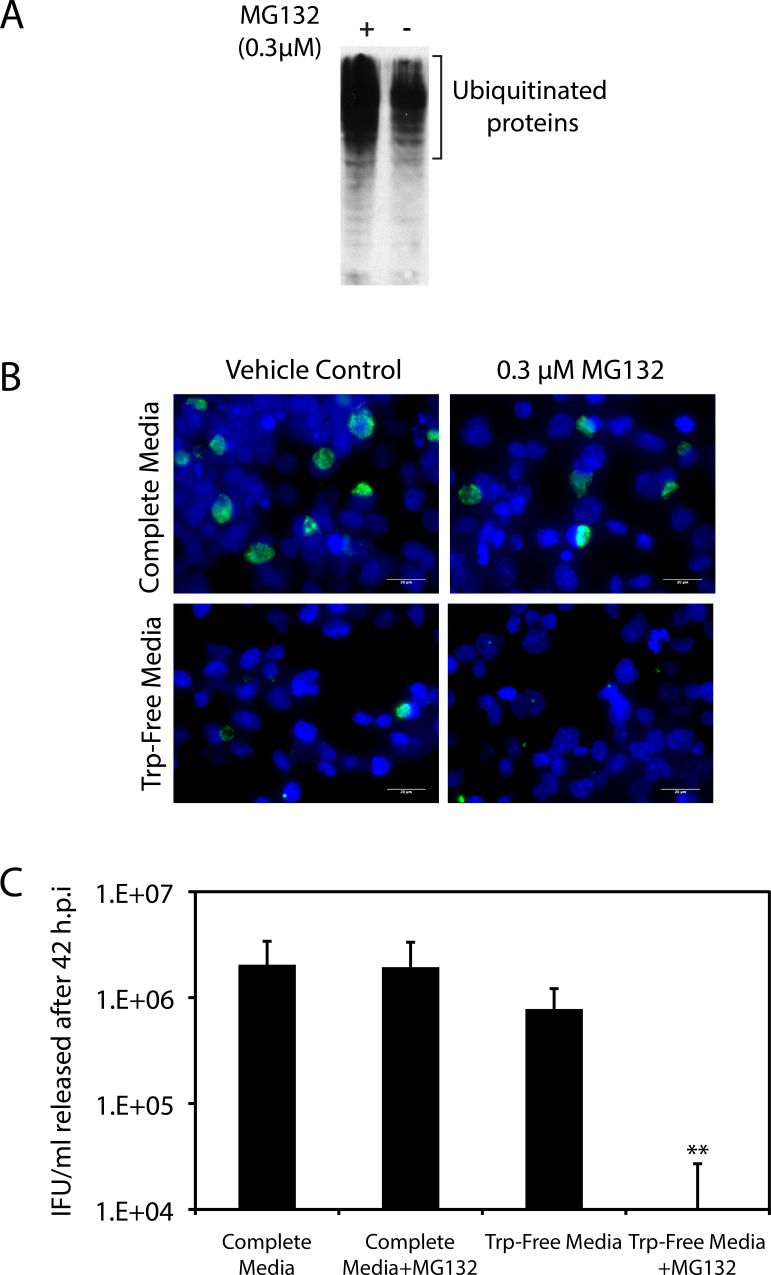
Proteasome activity is essential to support chlamydial development in C33A cells during tryptophan starvation.Immediately after infection with C. trachomatis, C33A cells were grown under four conditions: Complete media + vehicle control; Complete Media + 0.3 μM MG132; Trp-free media + vehicle control; and Trp-free media with 0.3 μM MG132. After 42 hours of growth under these conditions, inclusion development and IFU recovery was evaluated. A) Immunoblot evaluating the accumulation of polyubiquitinated proteins in C33A cells 24 hours post-exposure to the vehicle control or 0.3 μM MG132. The primary antibody used a rabbit polyclonal anti-ubiquitin antibody. B) Immunofluorescence using a FITC-conjugated anti-chlamydial LPS antibody was used to evaluate inclusion formation under the four conditions described above. Cells were counterstained with Hoechst dye. C) IFU/mL recovered 42 h.p.i. from cells grown under the four conditions described above. IFU recovery was quantified by infection of HeLa cells. The addition of 0.3 μM MG132 dramatically reduced IFU/mL released from C33A cells grown in Trp-Free Media (** indicates p < 0.001 by the Wilcoxon rank sum test). The bars represent the mean and standard deviation from three independent experiments.